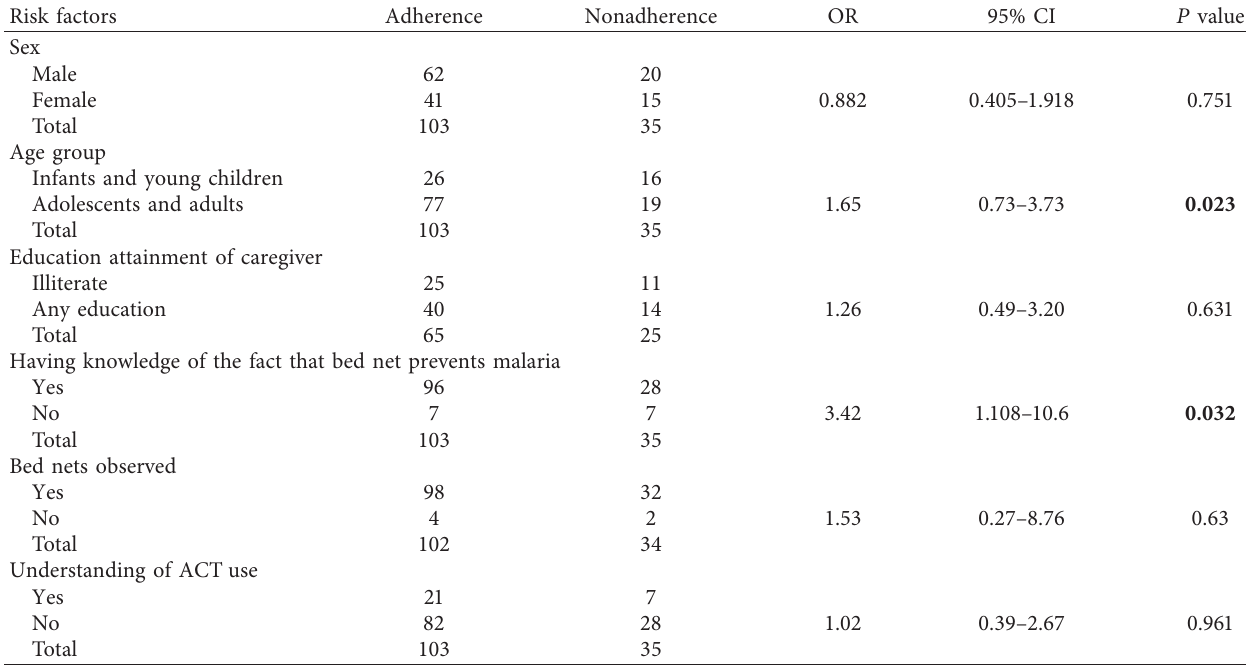
Table 5: Associated risk factors of adherence to DHP medication in Indonesia